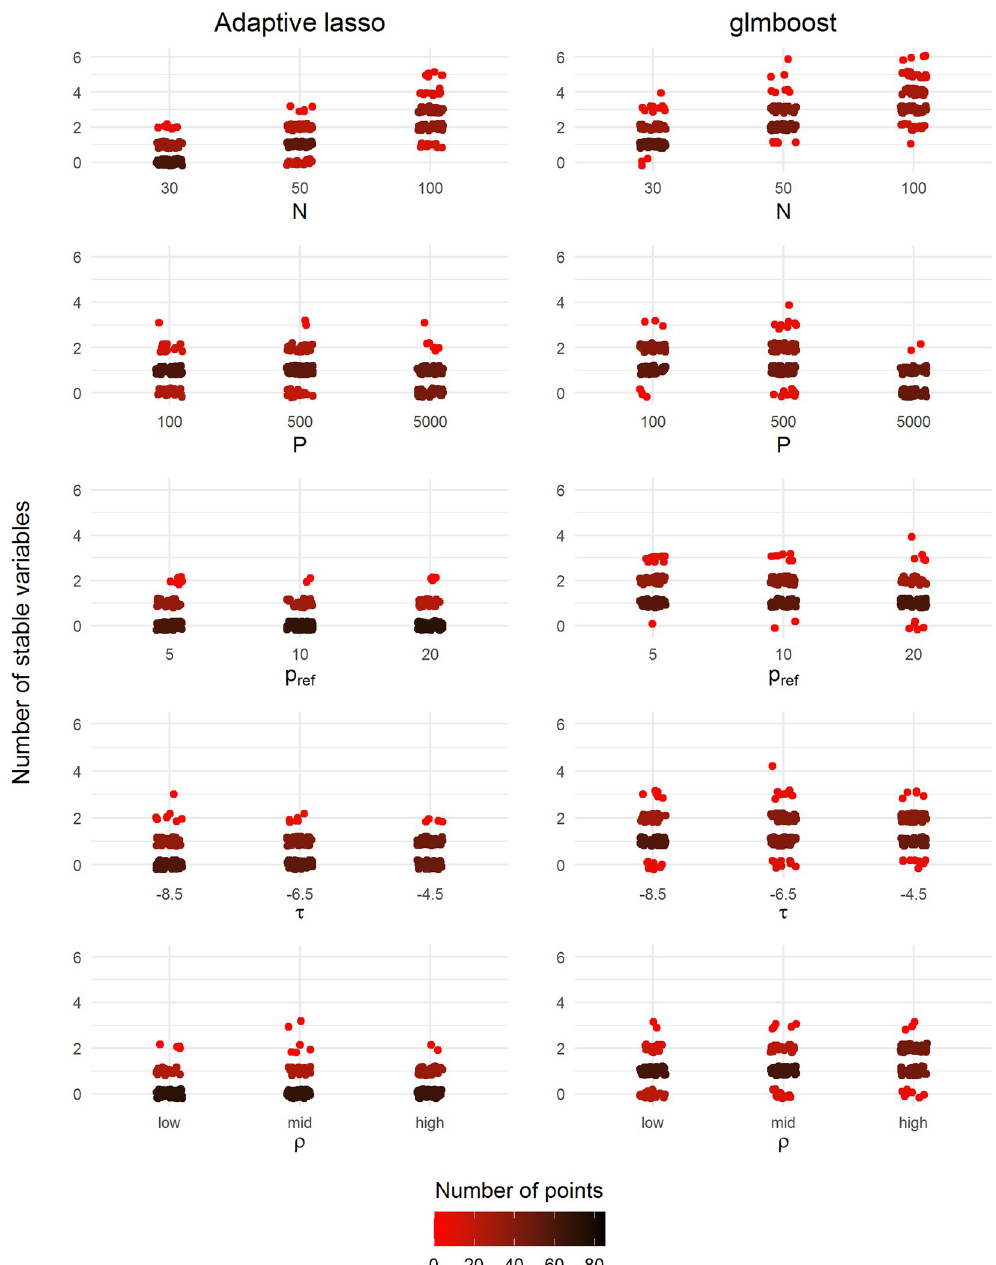
Fig 3. Number of selected stable variables in all scenarios using adaptive lasso and glmboost. The colors represent the number of jittered points (red: Low density, black: High density). A total number of 100 realizations of simulated datasets were drawn for each